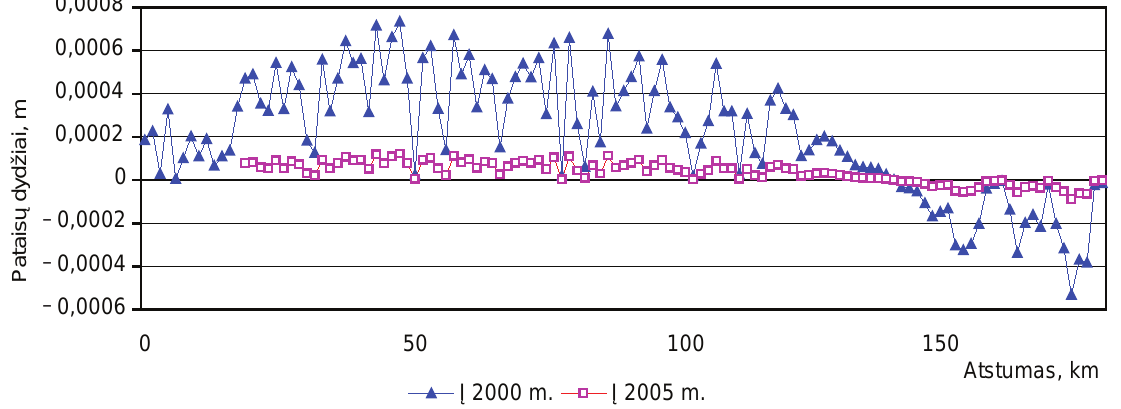
Fig. 1. The vertical movements of the Earth’s crust measured and described by multi-component regression models in the levelling line of Turmantas – Vilnius (1985/87–2005/06 m.)